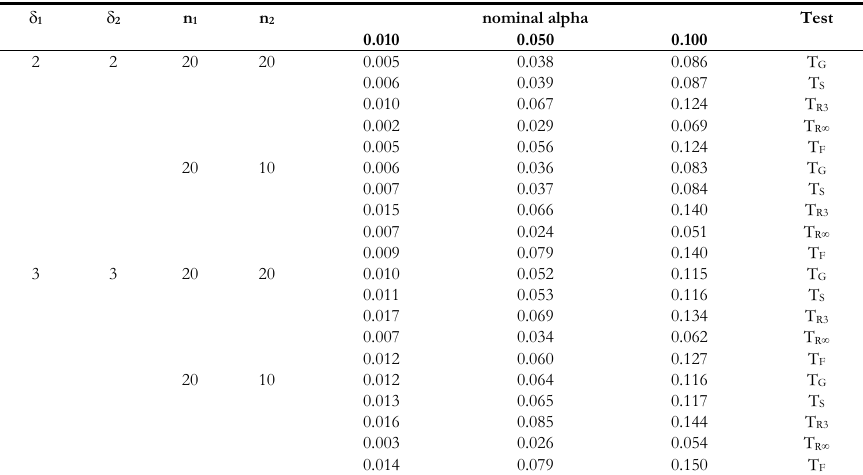
Rejection rates for the one-sided tests in the null